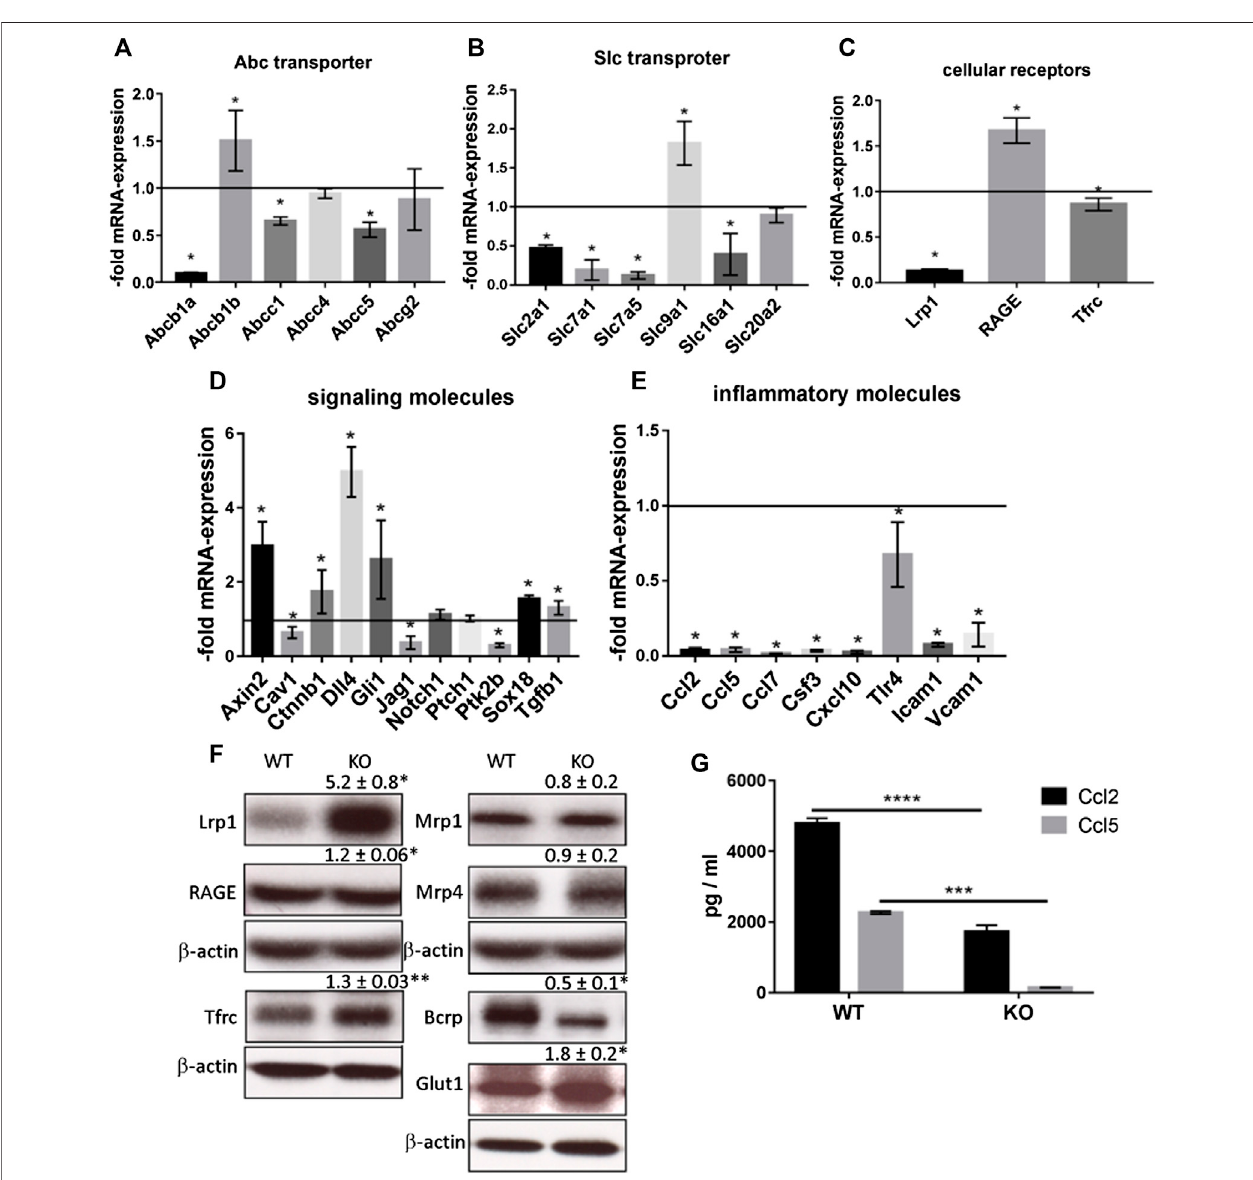
FIGURE3| Brain MicrovascularEndothelialCells lackingPcdhgC3 show differential geneand protein expression. Wild type and PcdhgC3 knockoutBMECswere grown to con fl uence, serum-starved for 24 h and harvested for RNA or protein extraction. Target gene expression of Abc transporter (A) , Slc transporter (B) , cellular receptors (C) ,signalingmolecules (D) andin fl ammatorymolecules (E) ,wasnormalizedtoendogenouscontrolandshownasfoldovercontrol(wildtypecells),whichwas arbitrarily set as 1 (control level marked in graph). (F) Protein expression of selected Abc transporter (Bcrp, Mrp1, Mrp4), Slc transporter (Glut1), cellular receptors (Lrp1, RAGE, Tfrc) was analyzed by Western blot. Protein expression was normalized to β -actin and to WT cells. The densitometry values are given above the corresponding bands. (G) Protein levels of Ccl2 and Ccl5 were analyzed by ELISA in cell culture medium of WT and KO cells. Data are shown as mean ± standard deviation of three independent experiments. * p < 0.05, ** p < 0.01, *** p < 0.001, **** p < 0.0001. Abbreviations (A) Abcb1a: P-Glycoprotein, ATP binding cassette subfamilyBmember1A,Abcb1b: P-Glycoprotein,ATPbindingcassettesubfamily Bmember 1,Abcc1: Mrp1,Multidrugresistance associatedprotein 1,Abcc4:Mrp4, Multidrug resistance associated protein 4, Abcc5: ATP binding cassette subfamily C member 5, Abcg2: BCRP, Breast cancer resistance protein (B) Slc2a1: Solute carrier family 2 member 1, Glut1, Glucose transporter type 1, Slc7a1: Solute carrier family 7 member 1, Cat1, Cationic amino acid transporter 1, Slc7a5: Solute carrier family7 member 5, Lat1, L-Type amino acid transporter 1), Slc9a1: Solutecarrier family 9 member 1, Nhe1, Cation proton antiporter 1, Slc16a1: Solute carrier family 16 member1,Mct1,Monocarboxylatetransporter1,Slc20a2:Solutecarrier family20member2,Pit2,Phosphatetransporter2 (C) Lrp1:Lowdensitylipoproteinreceptor- related protein 1, RAGE: Receptor for Advanced Glycosylation End Products, Tfrc: Transferrin receptor (D) Cav1: Caveolin 1, Ctnnb1: Catenin beta 1, Dll4: Delta like canonicalNotchligand4,Gli1:Familyzinc fi nger1,Jag1:JaggedcanonicalNotchligand1,Notch1:Notchreceptor1,Ptch1:Patched1,Ptk2b:Proteintyrosinekinase2 beta, Sox18: SRY-Box transcription factor 18, Tgfb1: Transforming growth factor beta 1 (E) Ccl2, 5, 7: C-C motif chemokine ligand 2, 5,7, Csf3: Colony stimulating factor 3, Cxcl10: C-X-C motif chemokine ligand 10, Tlr4: Toll like receptor 4, Icam1: Intercellular adhesion molecule 1, Vcam1: Vascular cell adhesion molecule 1.